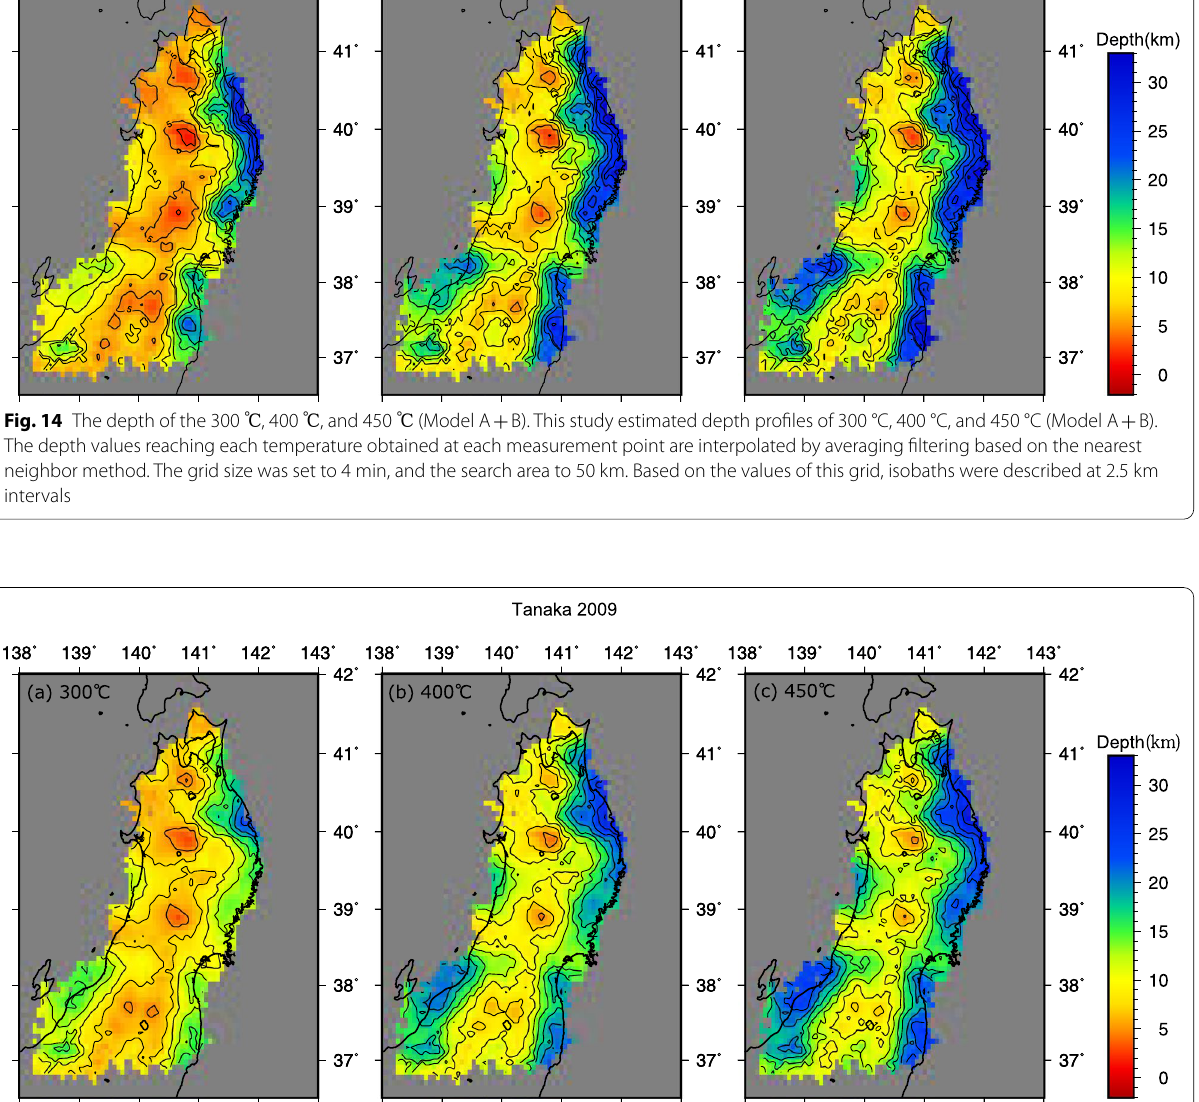
Fig. 15 The depth of the 300 ℃ , 400 ℃ , and 450 ℃ (Model C). The depth values reaching each temperature obtained at each measurement point are interpolated by averaging filtering based on the nearest neighbor method. The grid size was set to 4 min, and the search area to 50 km. Based on the values of this grid, isobaths were described at 2.5 km